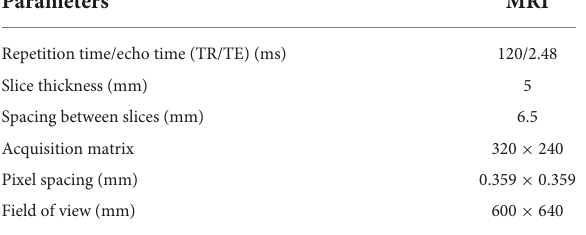
TABLE 1 Parameters of the brain MRI screenings.